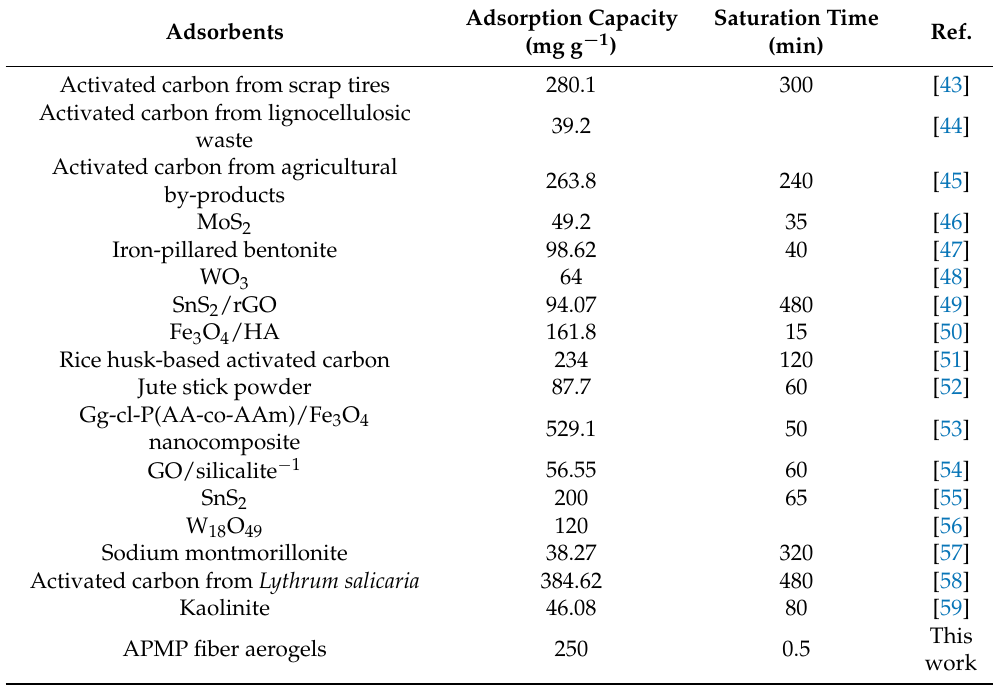
Figure 1. Adsorption process of rhodamine B (RB) waste dye by alkaline peroxide mechanical pulp (APMP) fiber aerogels within 30 s. Table 1. Comparison of the adsorption capacities of various adsorbents for RB.